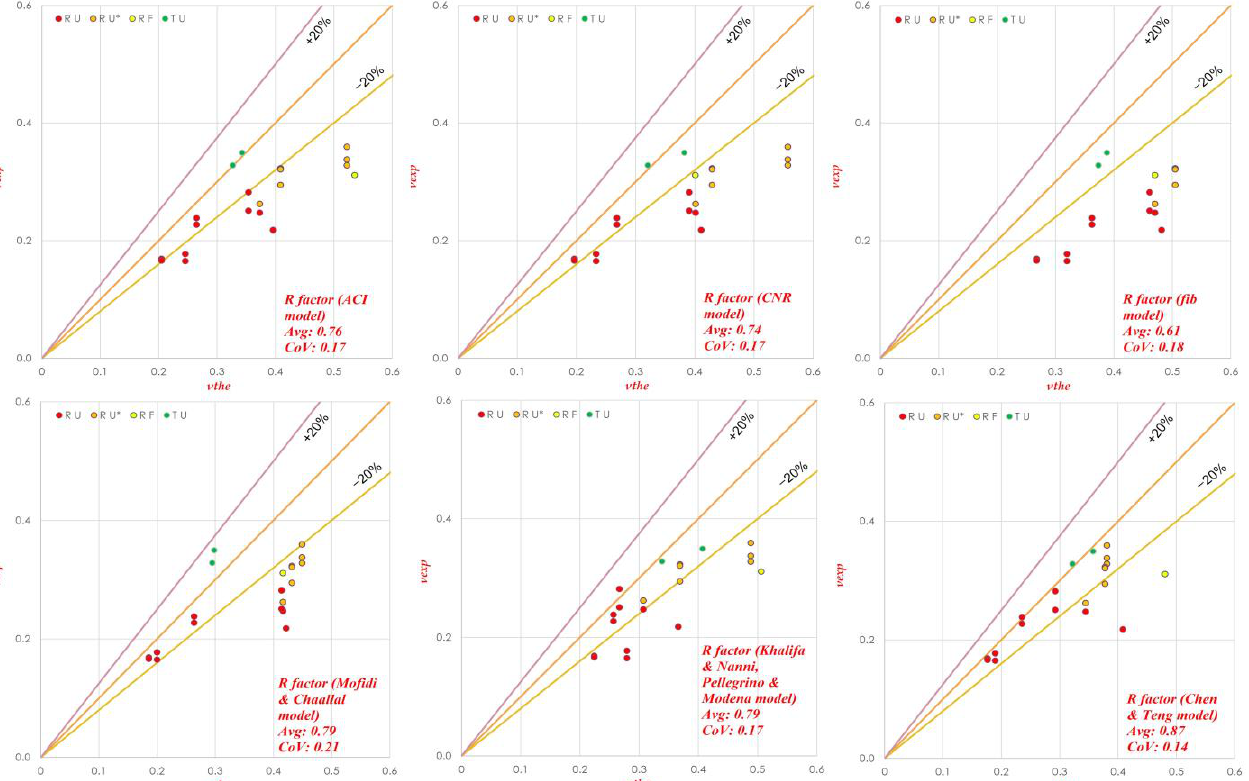
Figure 5. Shear strength calculation (experimental vs. theoretical) for the Colajanni et al. model with six different R factors. (For Data Set 2, α ≠ β ) . RU* represents Rectangular while TU* represents T beam having U-jacketing with partially efficient anchorages. Table 2. Results of calculation on the basis of the 1st and 2nd approaches from Database 1 and Database 2.